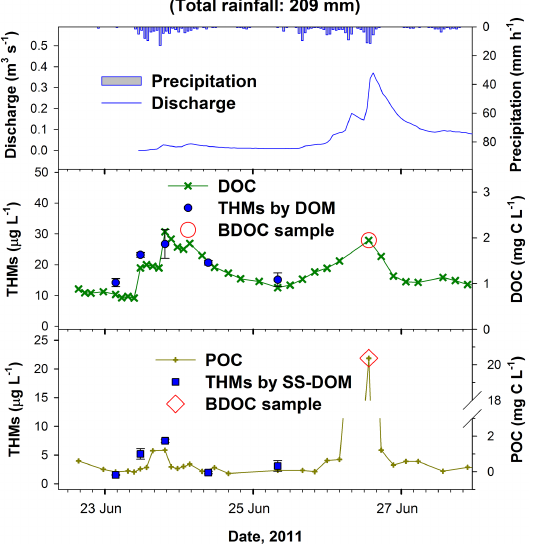
Figure 4. Temporal changes in the concentrations (mgCL − 1 ) of DOC and POC, and the potentials (µgL − 1 ) of TTHM formation by either DOM or suspended sediment-derived DOM (SS-DOM) over the course of the first storm event in 2011. Error bars indicate ± one standard error ( n = 3). BDOC sample refers to the samples of DOC or POC collected for the biodegradation incubation experi- ment (Fig. 5).